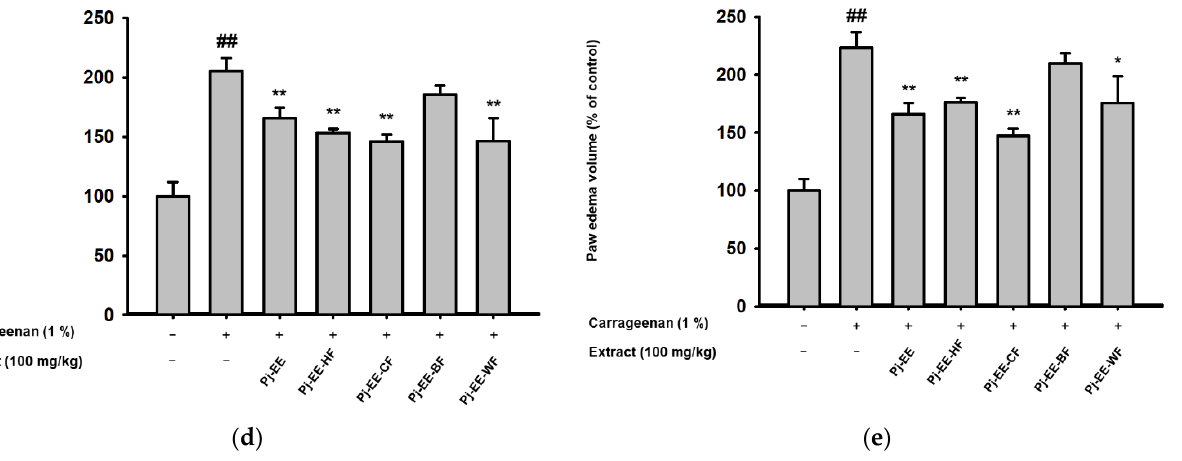
Figure 4. Effects of Pj-EE and four different solvent fractions on the carrageenan-induced acute paw edema mouse model. ( a ) Schematic of carrageenan-induced acute paw edema experiment. The ICR mice were orally treated with 100 μL of different solutions based on different groups for 10 days: a normal group (0.5% carboxymethylcellulose (CMC)) or carrageenan group as a control group (0.5% CMC), treatment groups (100 mg/kg Pj-EE, Pj-EE-HF, Pj-EE-CF, Pj-EE-BF, or Pj-EE-WF). Acute paw edema was triggered by an intraplantar injection of 1% carrageenan (100 μL/mouse) and mice were sacrificed after 3 h. ( b ) A representative photograph of paw inflammatory symptoms. ( c – e ) The severity of paw edema was evaluated by measuring the weight (c), thickness (d), and volume ( e ) of each paw of mouse. Results are expressed as mean ± standard deviation ( n = 12). ## p < 0.01 compared to normal group, and * p < 0.05 and ** p < 0.01 compared to control group (carrageenan alone). The p -value was analyzed using one-way ANOVA.